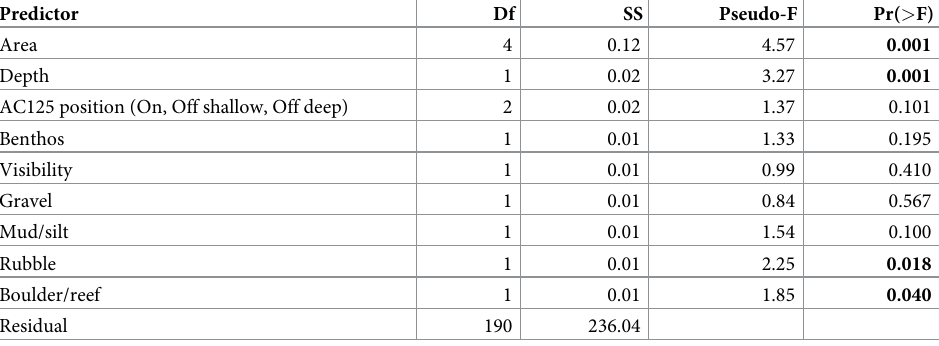
Significant predictors (see Table 1) are indicated in bold and represent where the modelled relationship was stronger than the randomly permuted relationships (at alpha = 0.05, beta = 0.01), SS is the sums of